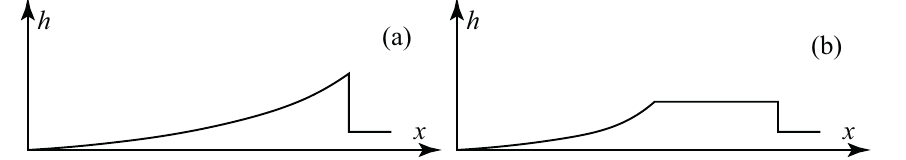
Figure 4. Avalanche for ( a ) σ ∗ ≥ ˆ σ ; ( b ) for σ ∗ < ˆ σ